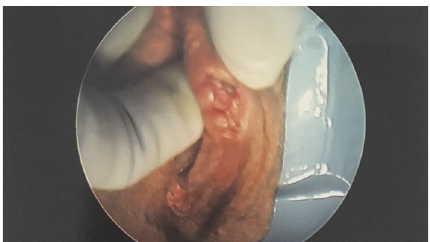
Figure 1: Previously sampled right vulvar mass containing mam- mary gland-like tissue taken by hysteroscopic camera. Image taken with permission from patient at time of surgery.